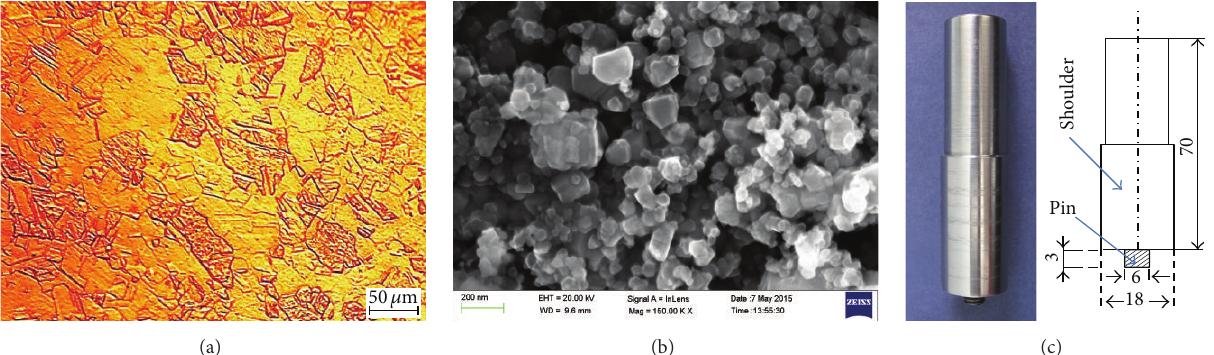
Figure 1: (a) OM of base metal, (b) FESEM of nanosized SiC particles, and (c) manufactured tool with its geometry.